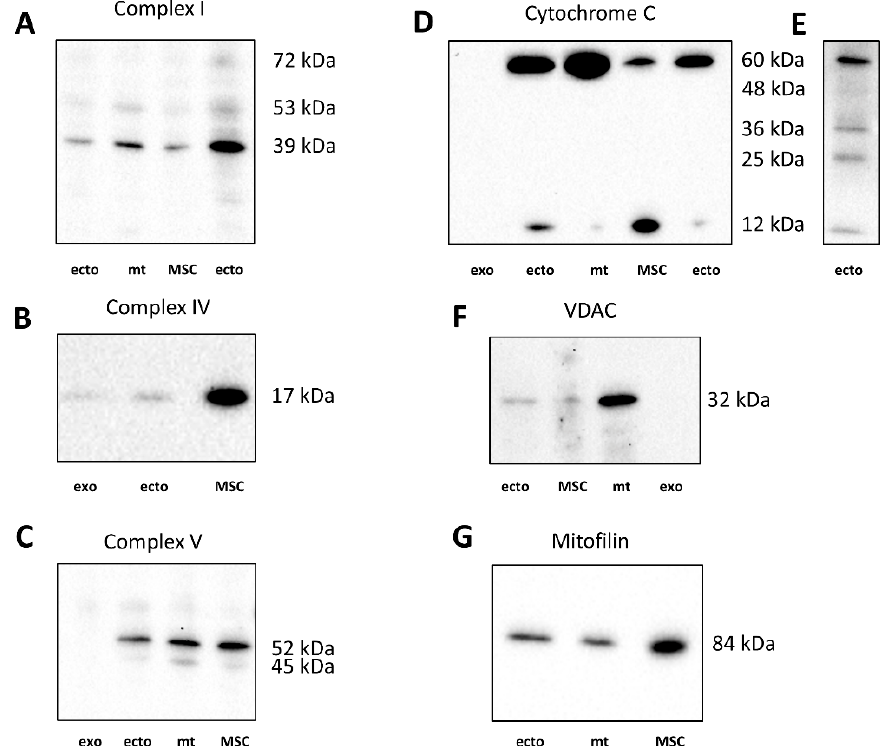
Figure 9. Western blots of vesicles (ectosomes, ecto and exosomes, exo), MSC, and mitochondria isolated from MSC. MWM with proper molecular masses were calculated based on molecular weight markers. For better representation of different forms of cytochrome C, the separate blot for ectosomes was made with more time exposure of the membrane. In the blot for complex I (with major 39 kDa component) in two separate lanes corresponding to ectosomes the proteins levels were different. For better demonstration of multiple forms, in the rightest lane in ( A ), the protein content of ectosomes was 4 times higher than in the very left lane (see details in Section 4 and explanations in the text). ( A – D ), probes for Complex I, Complex IV, Complex V and Cytochrome C, correspondingly; ( E ), example of resolution of bands for Cytochrome C in ectosomes; ( F , G ) probes for Complex V and